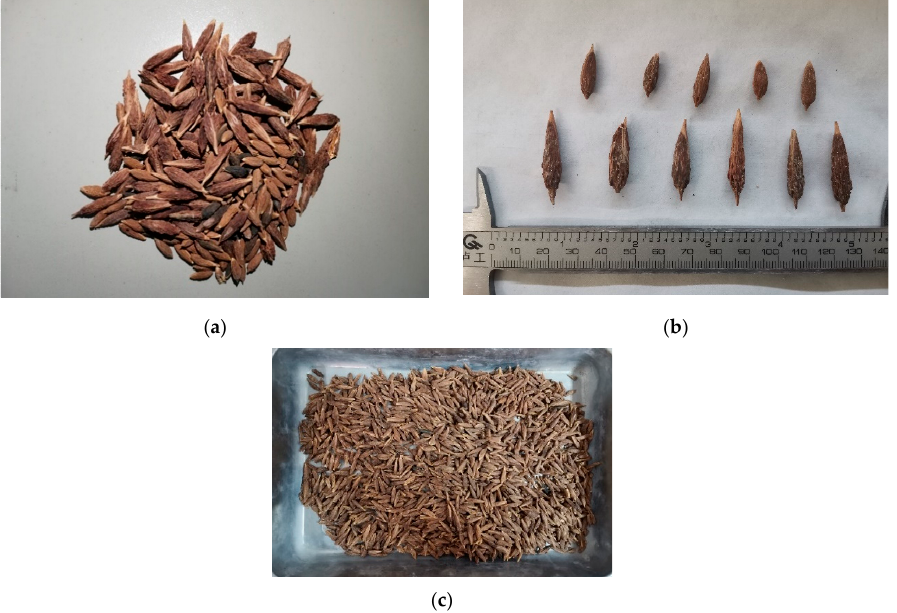
Figure 2. Jujube nuclei used in the test. ( a ) Jujube nuclei after pretreatment. ( b ) The particle size of jujube nuclei. ( c ) Jujube nuclei used in the specimen preparation. Table 2. Physical properties of jujube nucleus.